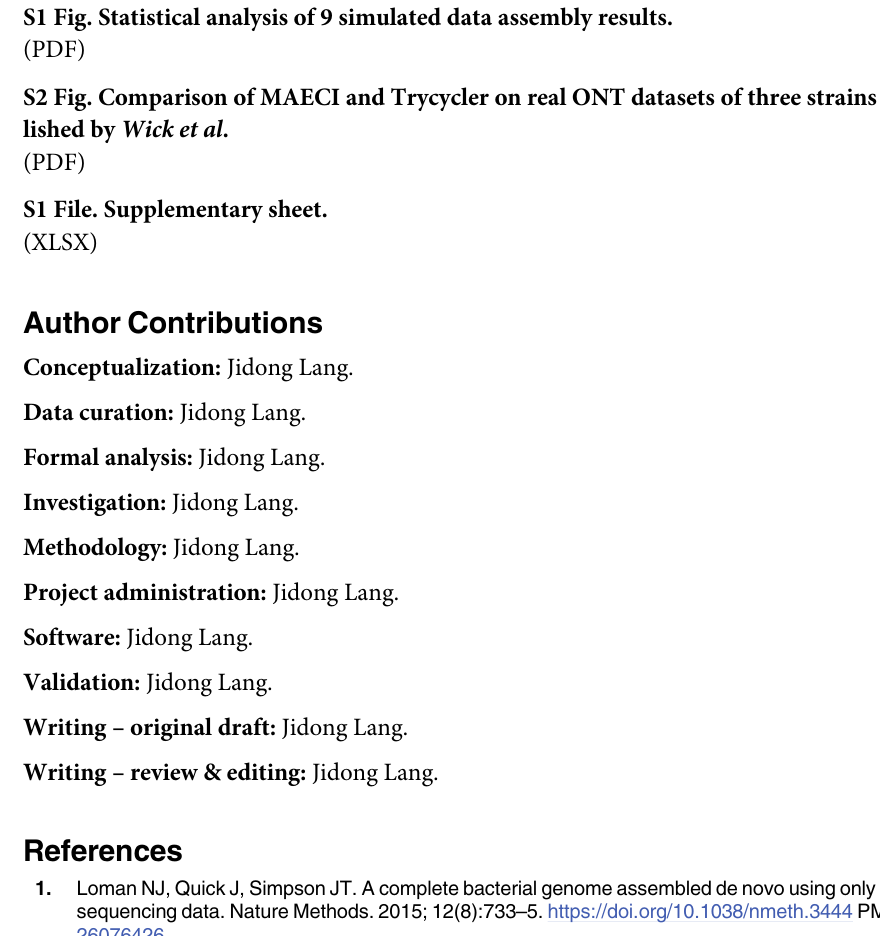
S1 Fig. Statistical analysis of 9 simulated data assembly results. S2 Fig. Comparison of MAECI and Trycycler on real ONT datasets of three strains